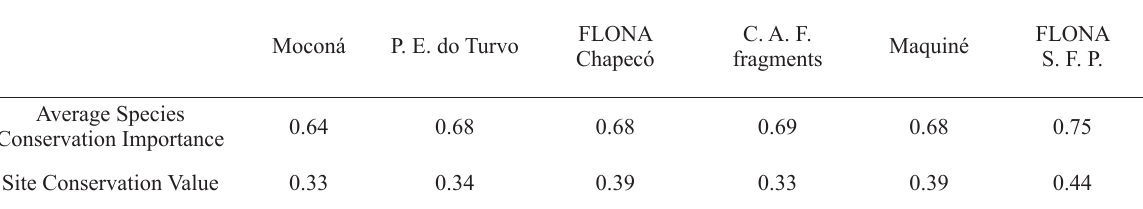
Average Species Conservation Importance and Site Conservation Value for each area, based on the four criteria established on pentatomids species: rarity, geographic distribution, economic significance and number of assemblage where the species is